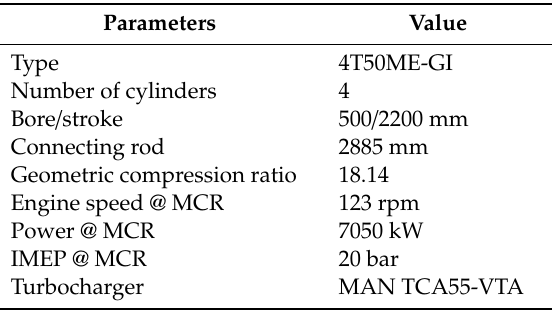
Table 1. Main specifications of the 4T50ME-GI research engine [23].